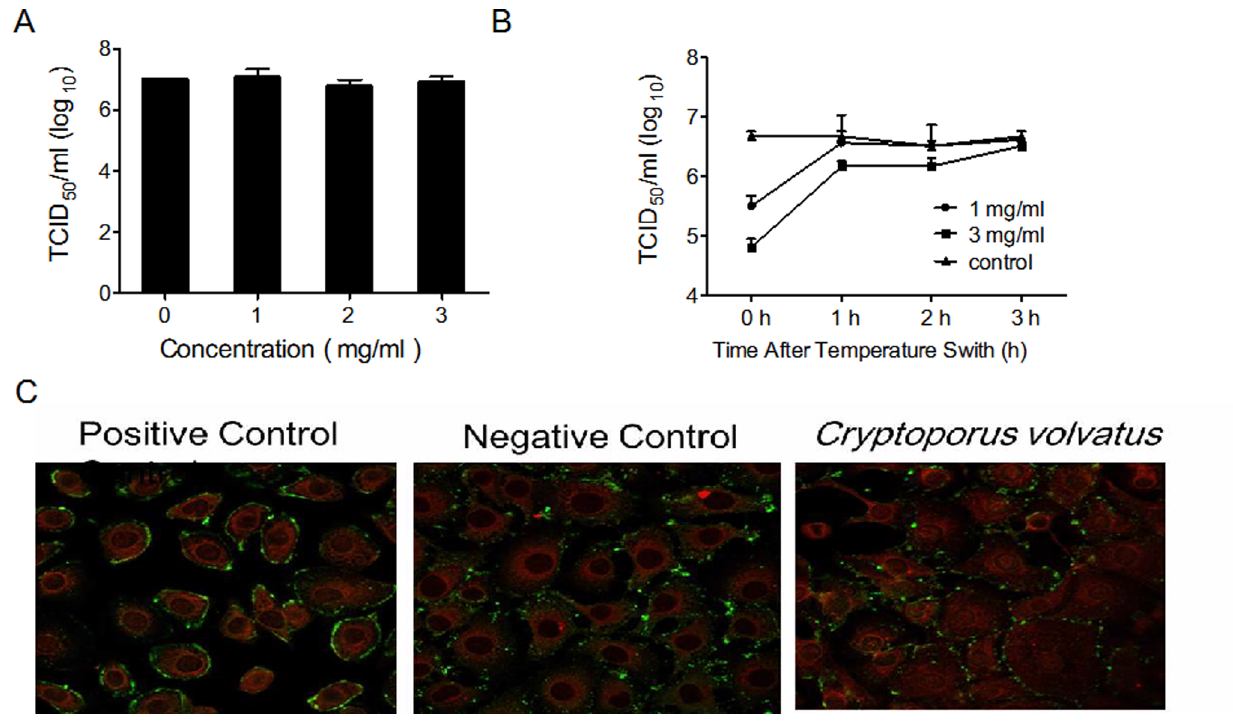
Figure 2. Cryptoporusvolvatus extract inhibits PRRSV entry into Marc-145 cell but not attachment. (A) Effects of the Cryptoporus volvatus extract on virus attachment. Marc-145 cells were inoculated with Ch1a (MOI=1) at 4 u C for 2 h with different concentrations of the extract, and then cell lysates were prepared by freeze-thaw three times after cells were washed 3 times with cold PBS. Virus titer (TCID 50 ) was determined. (B) Inhibition of PRRSV entry by the Cryptoporus volvatus extract. Marc-145 cells were incubated with Ch1a (MOI=1) at 4 u C for 2 h. Unbound virus was removed by washing three times with cold PBS, and the temperature was switched to 37 u C (this time point was set up as 0 h). Cell medium was replaced with fresh medium containing different concentrations of the extract at 0, 1, 2, or 3 h following temperature switch. Five hours after temperature switch, medium was replaced with fresh medium, and cells were further incubated at 37 u C. Twenty-four hours later, supernatants were harvested for virus titration. (C) Confocal analysis showing that Cryptoporus volvatus extract inhibits PRRSV entry into Marc145 cells. Marc-145 cells were incubated with Ch-1a (MOI=50) at 4 u C for 2 h. And then, cells were fixed with cold methanol-acetone after 3 washes with cold PBS (negative control) or continued to be cultured in fresh medium with or without (positive control) the Cryptoporus volvatus extract at 37 u C for another 3 hours before being fixed with cold methanol-acetone after 3 washes with cold PBS. Fixed cells were stained for PRRSV N protein and labeled with Phalloidin -TRITC (Sigma). Immunofluorescence was observed using Leica Microsystems CMS GmbH. Data are representative of three independent experiments (mean 6 SD). Statistical significance was analyzed using Student’s t test . mune PRRSV-specific globulin. The hyperimmune globulin was titrated so that it neutralized as much infectious units of PRRSV as the amount produced in the infected culture cells in the absence of the extract. And in this condition, PRRSV could only spread by the way of cell-to-cell infection. Marc-145 cells were infected at an MOI of 0.0l, and globulin was added immediately thereafter. We observed a reduction of PRRSV-infected cells and the formation of discrete infected foci by addition of antibody in the absence of the extract using immunofluorescence assay compared to untreat- ed controls (not shown here), suggesting that the cell-free virus spreading is prevented. When the extract was added, the size of the isolated PRRSV-infected foci was decreased in a dose- dependent manner (Fig. 4C). At twenty-four hours after infection, even the lowest concentration (1 mg/ml) of the extract tested remarkably reduced the size of infected foci (from , 65 to 18 infected cells), and the average number of cells in an infected foci was only 1.25 when the extract was used at 3 mg/ml (Fig. 4D). Taken together, our results indicated that the Cryptoporus volvatus extract could inhibit PRRSV cell-to-cell spread.